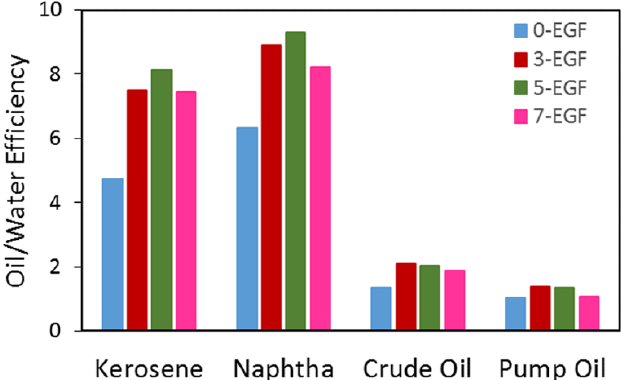
Figure 3. Selectivity oil / water of all composite silicone foams.